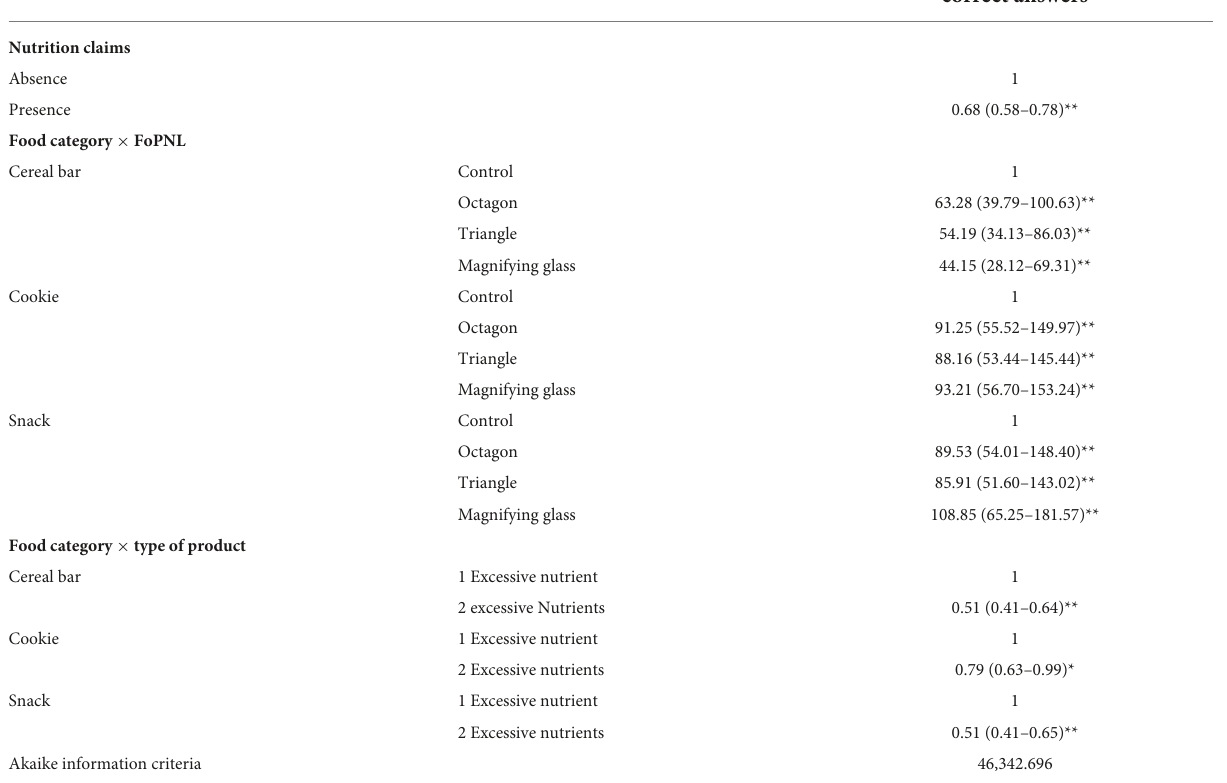
TABLE 4 Odds ratios (IC95%) of the significant effects and interactions of the model in the understanding of nutritional information. Effect